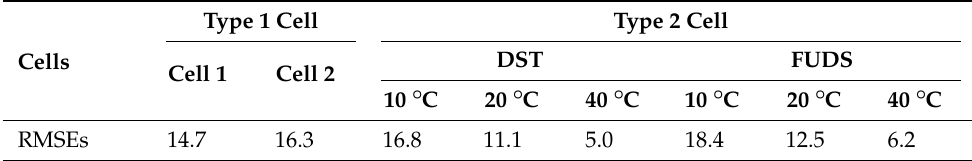
Table 4. RMSEs (mV) of predicted terminal voltages based on battery model for different datasets.